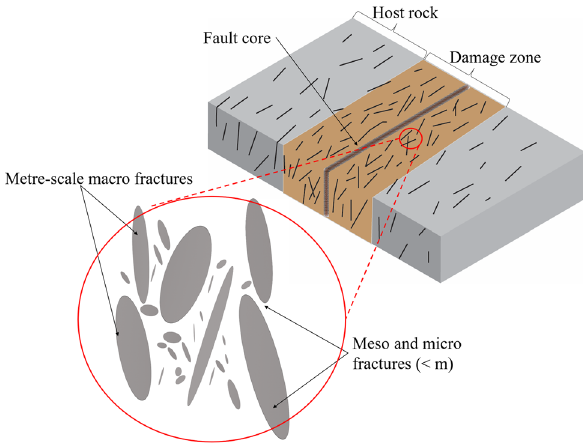
Fig. 1 Characteristics of fractures in a fault